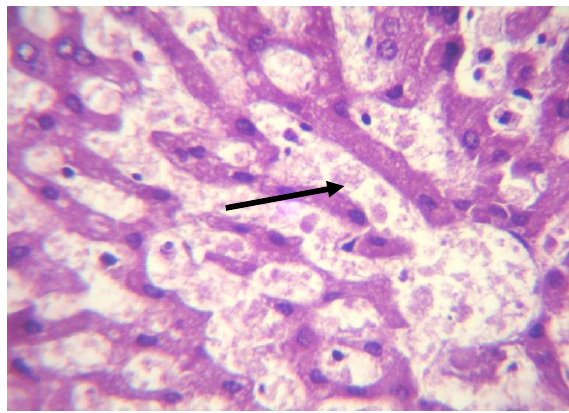
Fig 13: Microscopic section of intestine from 1st immunized group at 20 days post challenge show MNCs infiltration in lamina propria of intestinal villi (H&E X20).